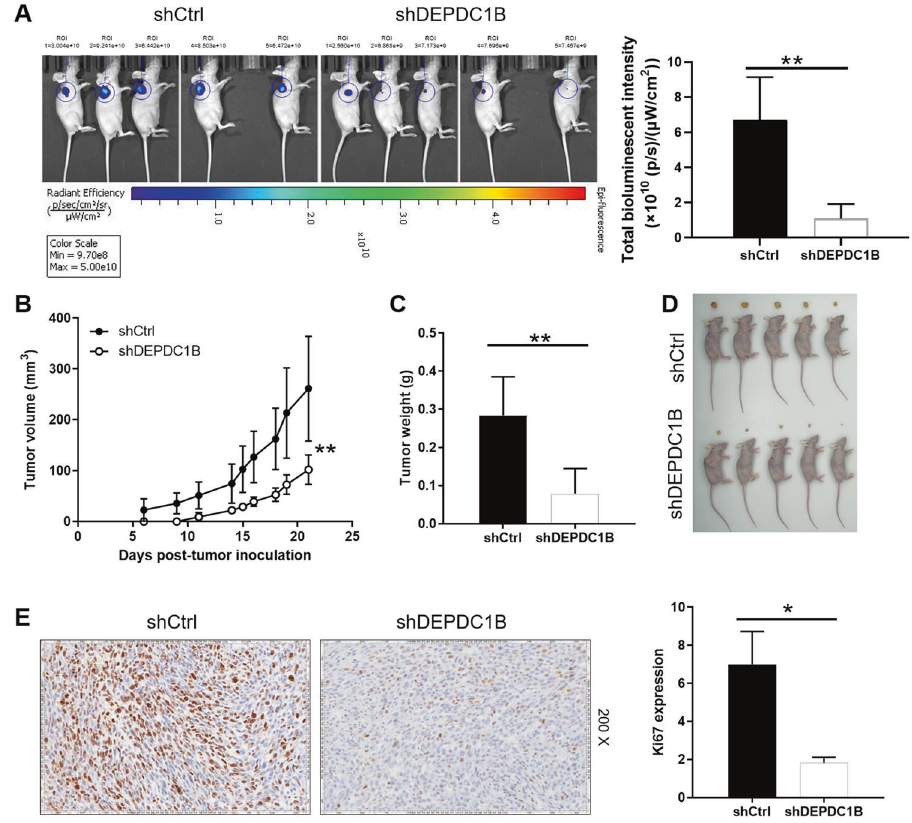
Fig. 3 Knockdown of DEPDC1B inhibits tumor growth in mice xenograft models. A The total bioluminescent intensity of tumors in shCtrl group and shDEPDC1B group. B The volume of tumors in shCtrl group and shDEPDC1B group was measured after post-injection. C The average weight of tumors in shCtrl group and shDEPDC1B group. D Images of mice and tumors in shCtrl group and shDEPDC1B group. E The Ki67 staining of tumor tissues in shCtrl group and shDEPDC1B group. Data were represented as mean ± SD. * P < 0.05, ** P <